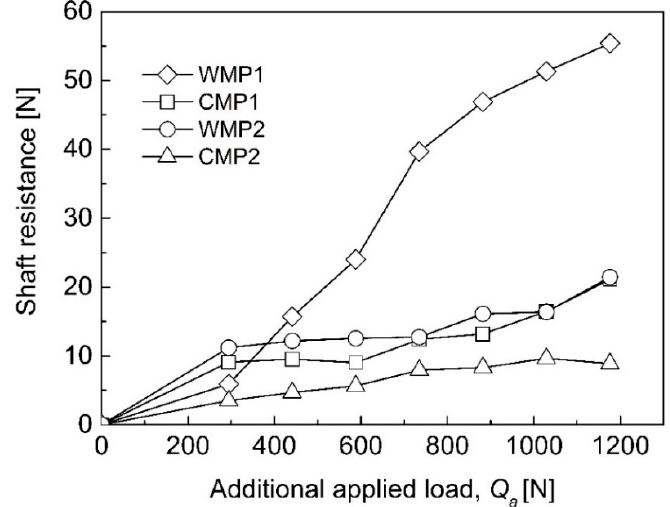
Figure 9. Shaft resistance of the underpinning micropiles with respect to the additional load applied to the foundation.